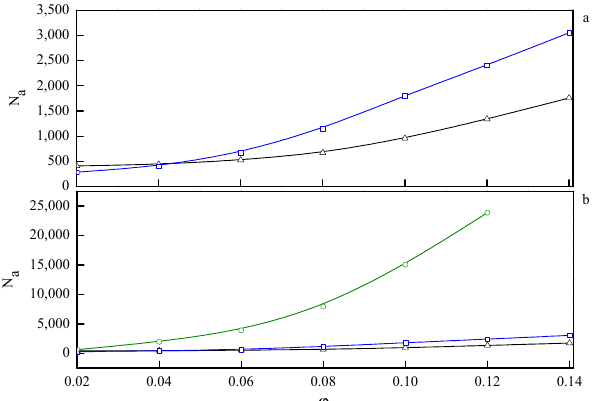
Figure 6. The dependence of the aggregation number, N a , on the volume fraction, φ , for three selected temperatures: T* = 1.3 ( ∆ —triangle), T* = 3.0 ( □ —squares), and T* = 4.7 ( ○ —circles). On ( a ) the highest temperature is omitted to emphasize the behaviour at lower temperatures. On ( b ) on the other hand N a is on a logarithmic scale for clarity